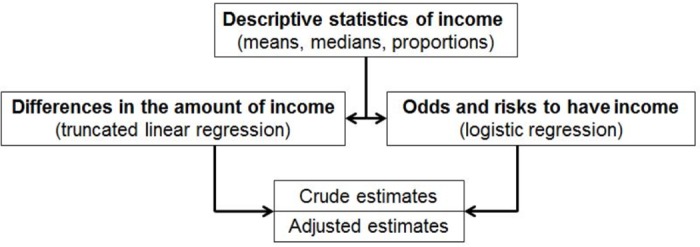
Analysis approach.